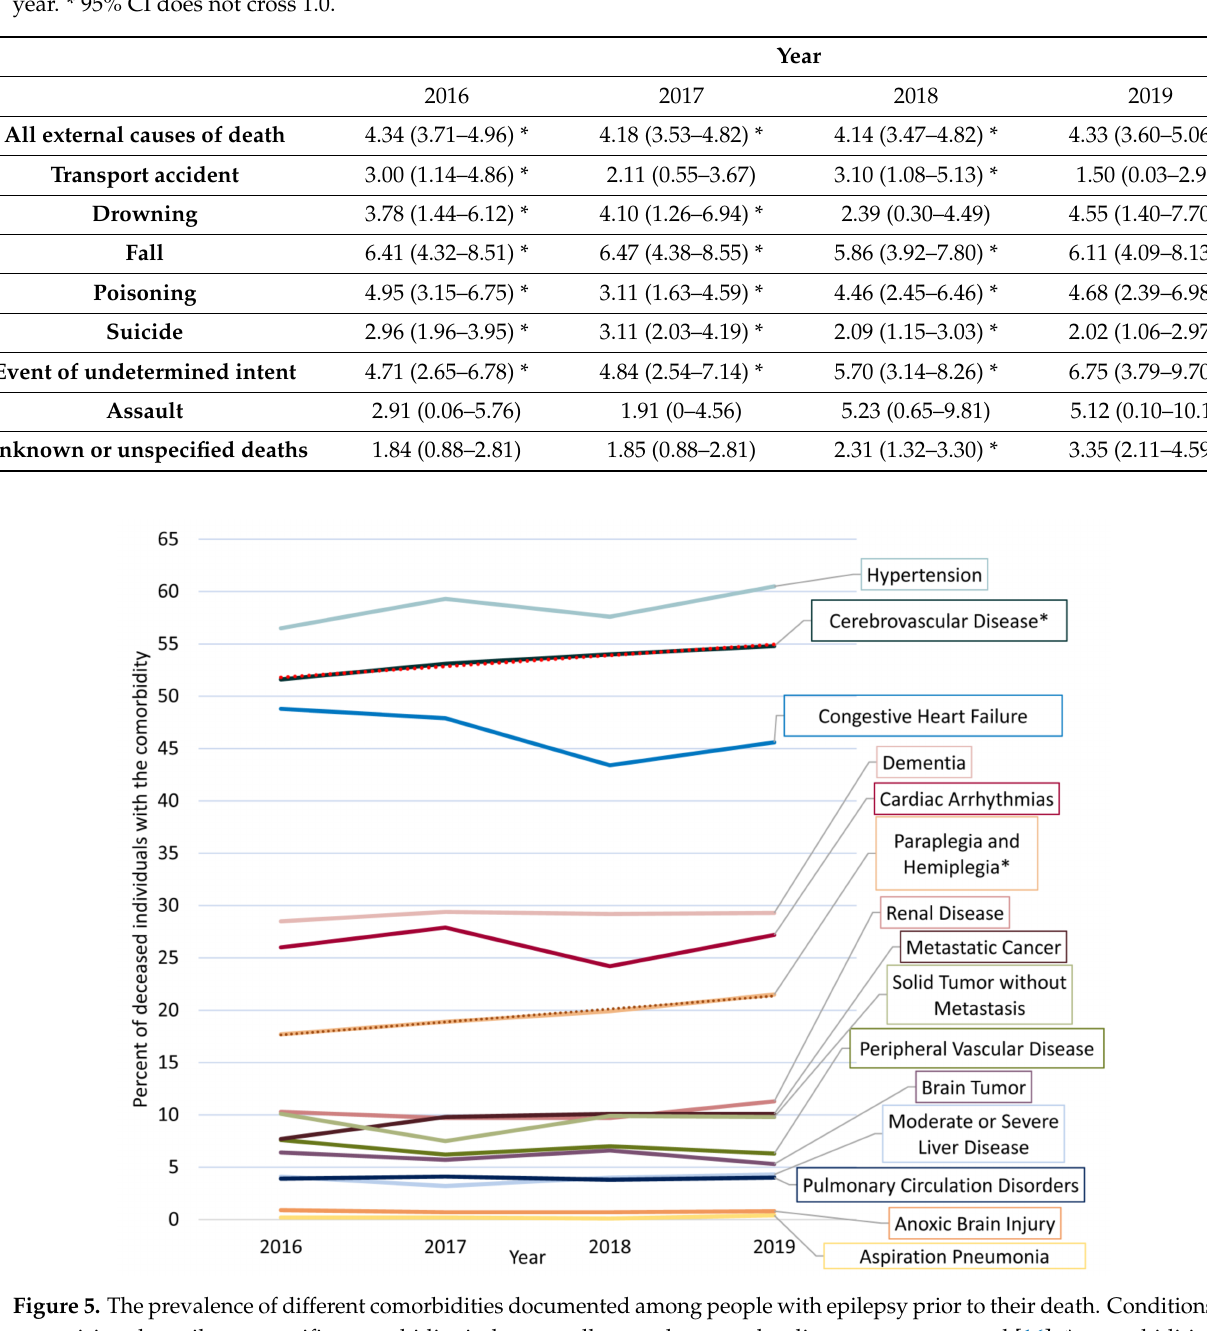
Table 3. External and unknown causes of death (standardized mortality ratios and 95% confidence intervals (CIs)) each year. * 95% CI does not cross 1.0.